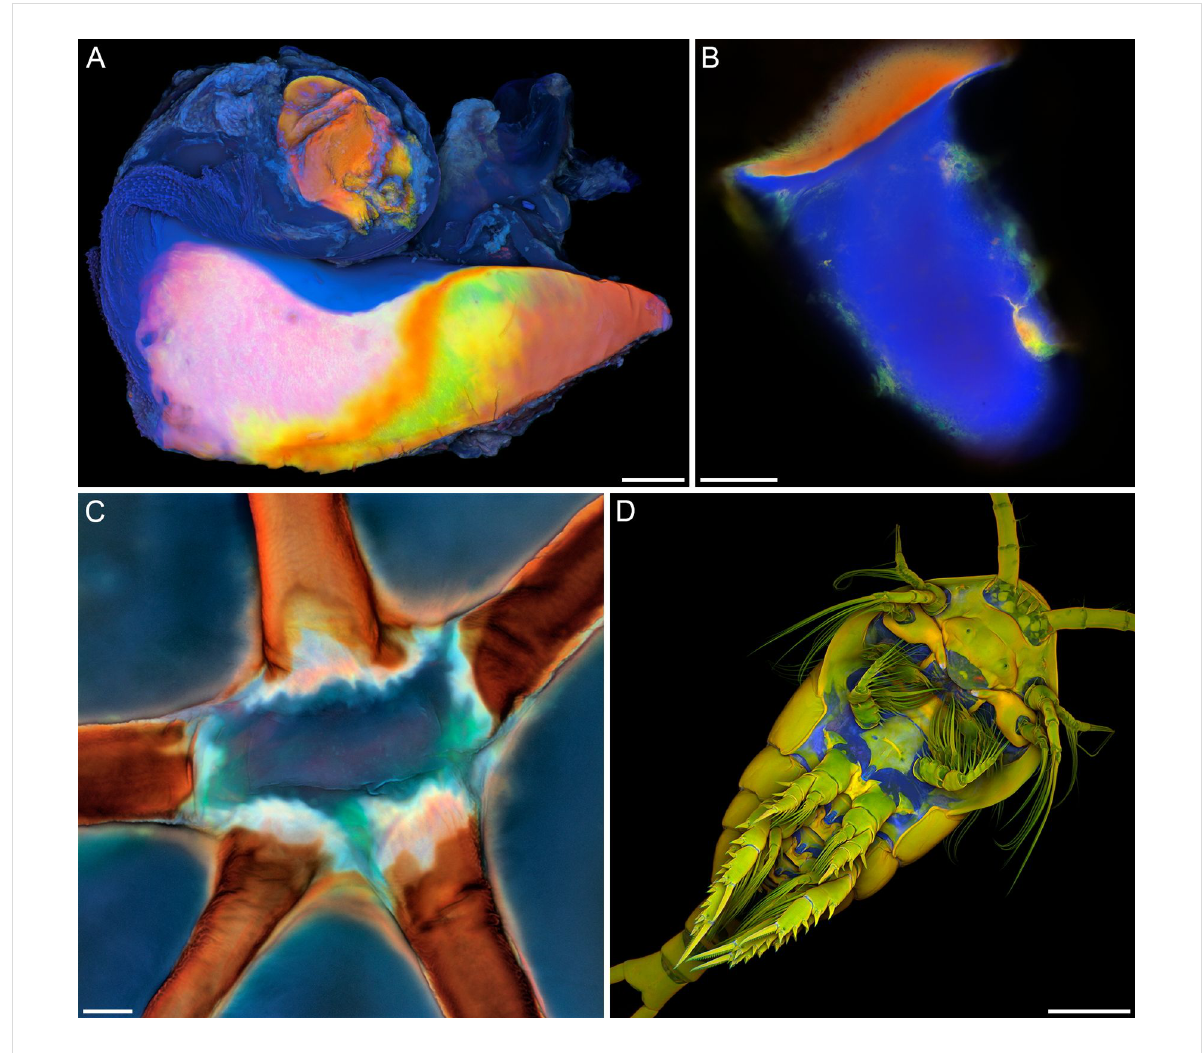
Figure 1: Occurrence of resilin in insects and crustaceans. Confocal laser scanning micrographs showing a wing hinge (A) and a prealar arm (B) of the migratory locust ( Locusta migratoria ), a wing vein joint of the common darter ( Sympetrum striolatum ) (C) and the ventral side of a female copepod of the species Temora longicornis (D). (A–C) Overlays of four different autofluorescences exhibited by the exoskeleton. Blue colours indicate large proportions of resilin, while green structures consist mainly of non- or weakly-sclerotised chitinous material, and red structures are composed of rela- tively strongly sclerotised chitinous structures. (D) Blue = autofluorescence of resilin, red = Congo red fluorescence of stained chitinous exoskeleton parts, green = mixture of autofluorescence and Congo red fluorescence of stained chitinous exoskeleton parts. (A, C, D) Maximum intensity projec- tions. (B) Optical section. Scale bars = 100 µm (A, B), 20 µm (C), 200 µm (D). (A–D) Adapted with permission from [10], copyright 2011 John Wiley and